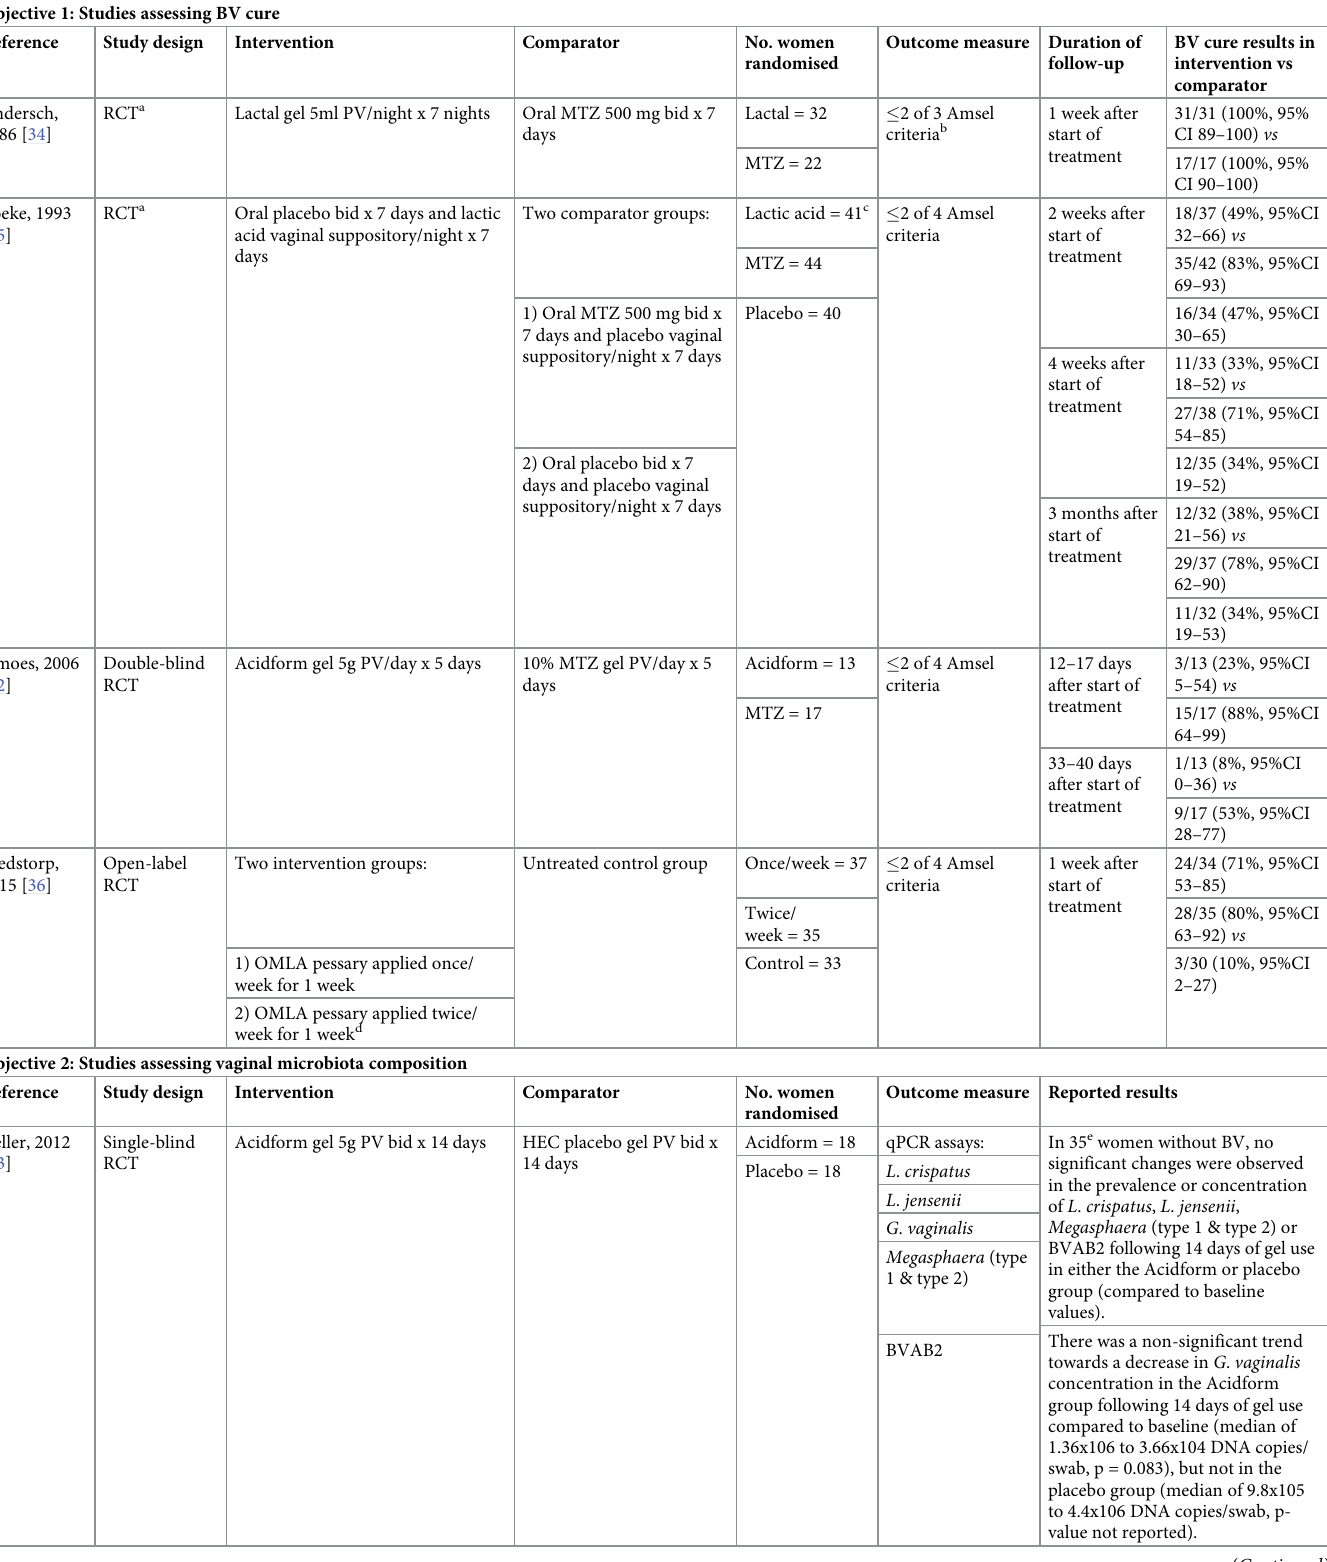
Table 2. Key findings of included